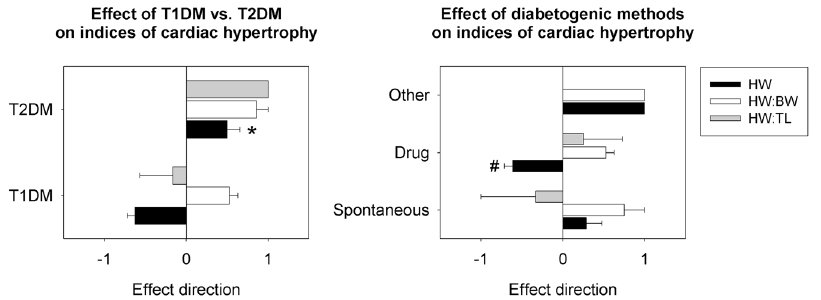
Figure 2. Effect of diabetes type and methods of diabetogenicity on indices of cardiac hypertrophy in experimental rodent models of diabetes. The type of diabetes and the method of inducing diabetes significantly affect absolute heart weight but not the HW:BW index in rodent models of diabetes. * significant effect of diabetes type; # significant effect of diabetogenic from both other categories. Significance set at P , 0.05. T1DM = type 1 diabetes mellitus; T2DM = type 2 diabetes mellitus; HW = heart weight; BW = body weight; TL = tibia length.